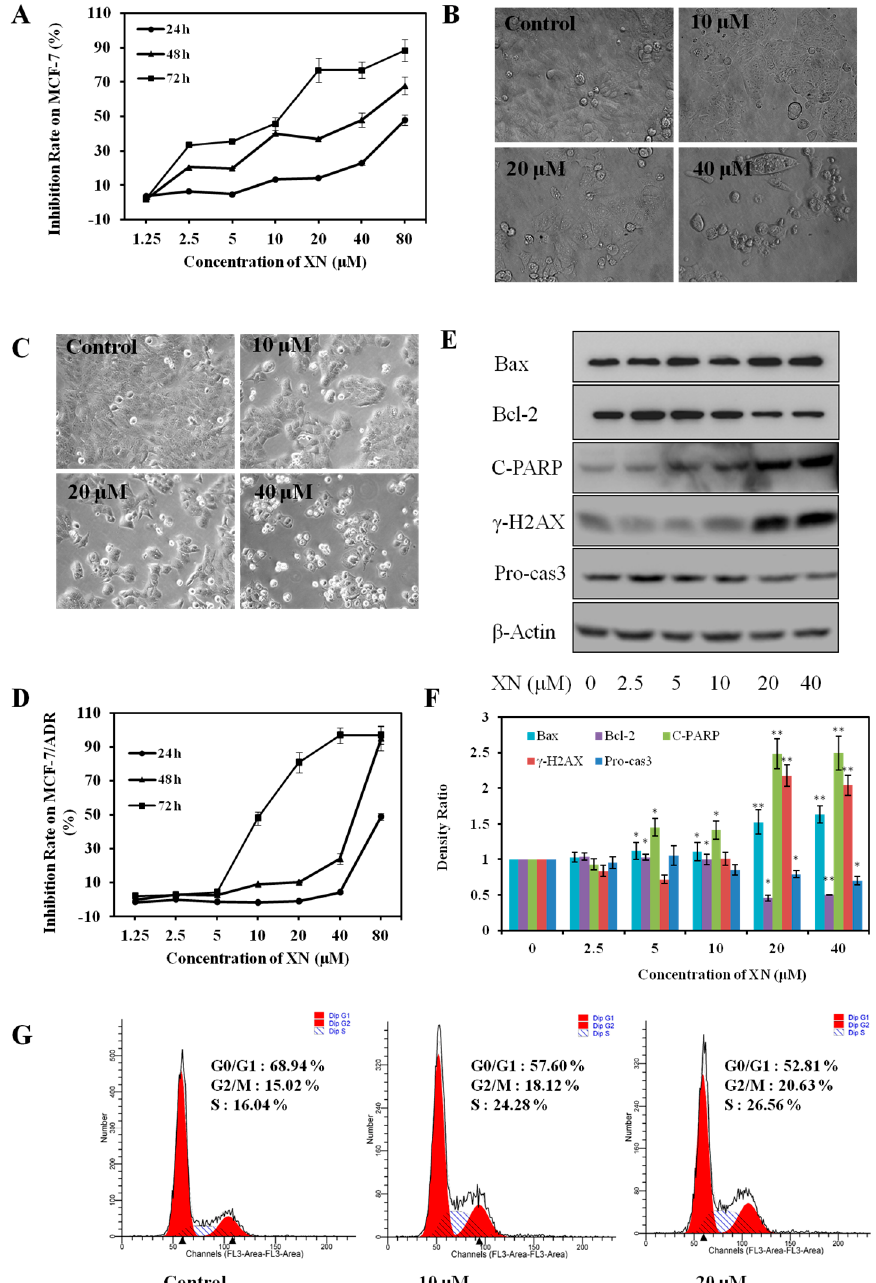
Figure 2. Both MCF-7 and MCF-7/ADR cell lines are sensitive to XN. ( A ) XN inhibits the viability of MCF-7 cells in a concentration- and time-dependent manner. Cells were treated with indicated concentrations of XN for 24, 48, and 72 h, respectively, and then tested by MTT assay; ( B ) XN decreases the population of MCF-7 cells in vitro (×400); ( C ) XN decreases the population of MCF-7/ADR cells in vitro. Cells were treated with XN (0–40 μ M) for 48 h in 6-well plate, and observed by inverted microscope (400×); ( D ) XN inhibits the viability of MCF-7/ADR cells in a concentration- and time-dependent manner. Cells were treated with indicated concentrations of XN for 24, 48, and 72 h, respectively, and then tested by MTT assay; ( E ) XN induces apoptosis in MCF-7/ADR cells. Cells were treated with XN (0–40 μ M) for 48 h, and the apoptosis related proteins were detected by Western blotting; ( F ) protein levels quantified by scanning densitometry and normalized to control. Results are expressed as the ratio of control. Data represent means ± SD from three independent experiments. * p < 0.05, ** p < 0.01 for control cells versus XN treated cells; and ( G ) XN affects the cell cycle distribution in MCF-7/ADR cells. Cells were treated with XN (0–20 μ M) for 24 h, fixed, stained with PI, and detected by flow cytometry.